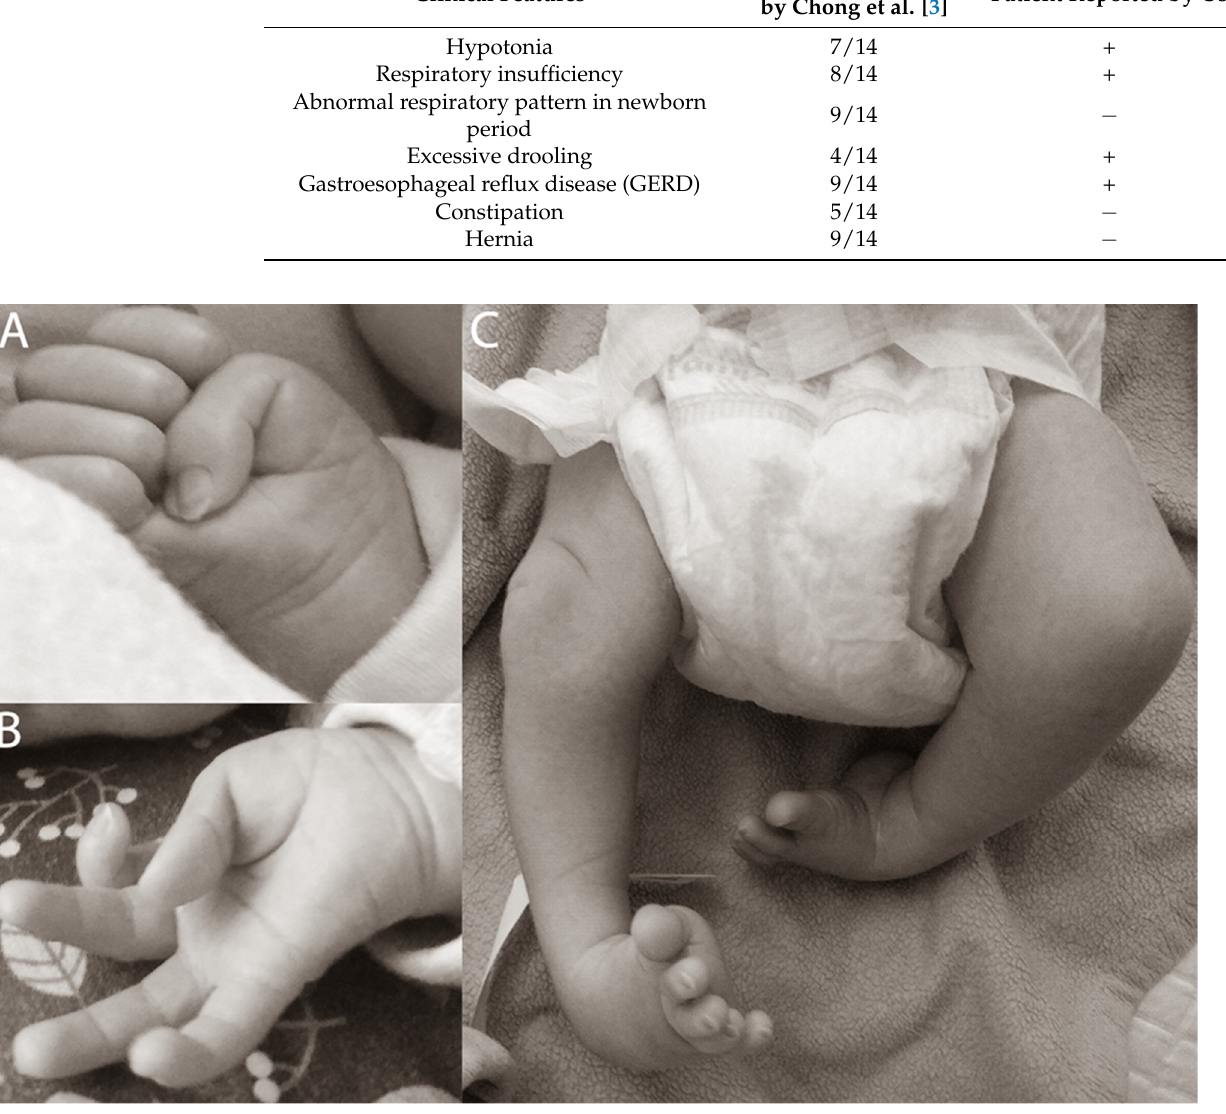
Figure 1. Clinical features in the proband during the neonatal period. The characteristic pattern of limb contractures presenting as ( A , B ) adducted thumbs, ( C ) feet, less obvious knees contractures, and equinovarus deformities of feet are shown. Table 2. The comparison of the clinical symptoms described by Chong et al. [3] with the patient’s